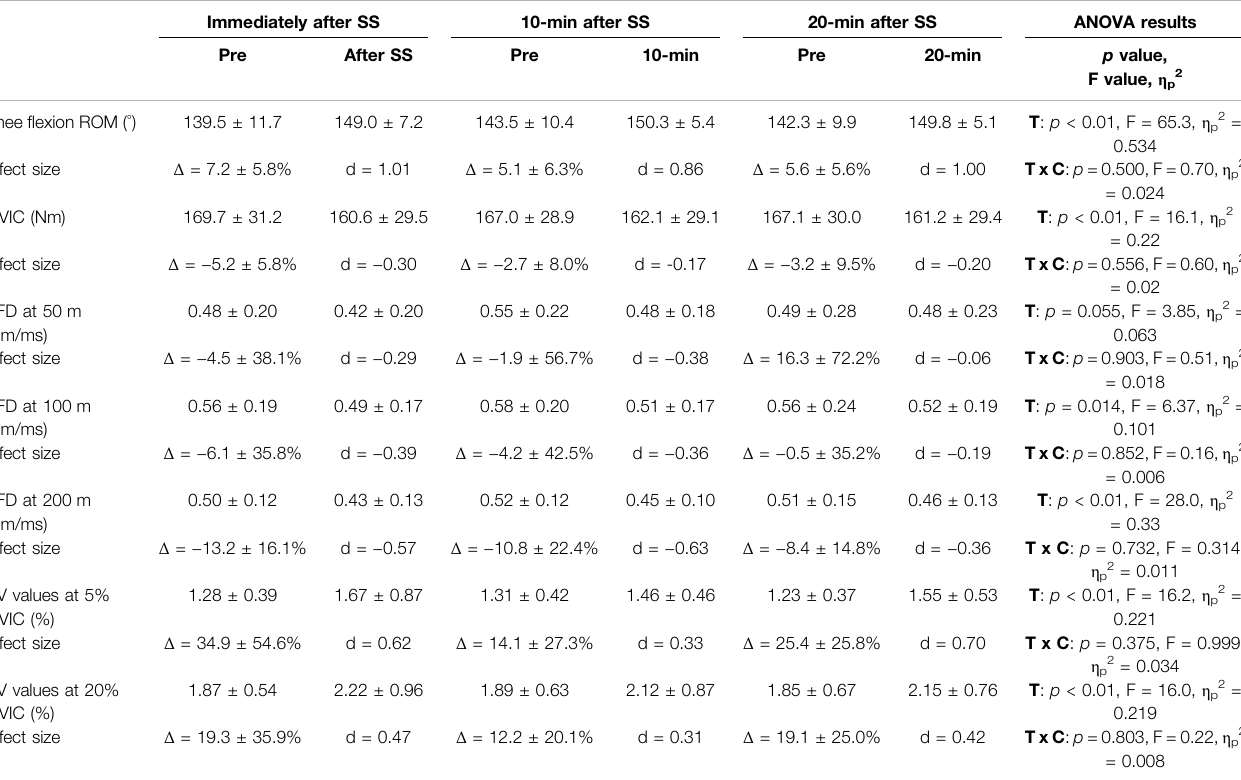
TABLE 1 | Changes (mean ± SD) in knee fl exion range of motion (ROM), maximal voluntary isometric contraction (MVIC) torque of the knee extensors, rate of force development (RFD) at 50, 100, and 200 m, and coef fi cient of variation (CV) values at 5 and 20% MVIC before (pre) and immediately after, 10 min after, and 20 min after thestaticstretching(SS)intervention.Thetwo-wayANOVAresults(T:testtimeeffect,T×C:testtime×conditionsinteractioneffect;F-value)andpartial η 2 ( η p2 )areshownin the right